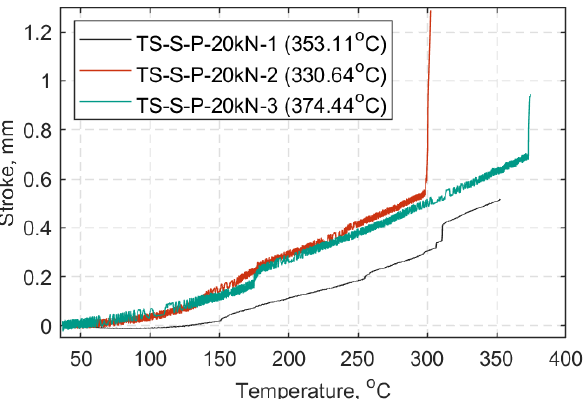
Figure 24. Crosshead stroke in hold mode (mm) vs. temperature (°C): All TS cases at 20 kN.